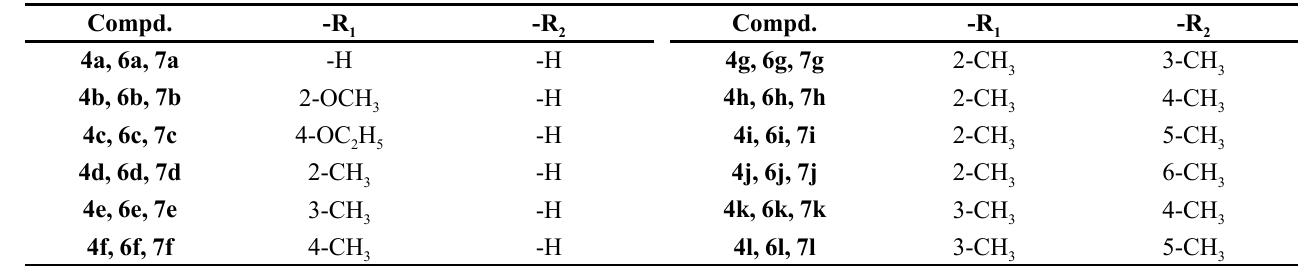
& -R ) in scheme 1 1 2